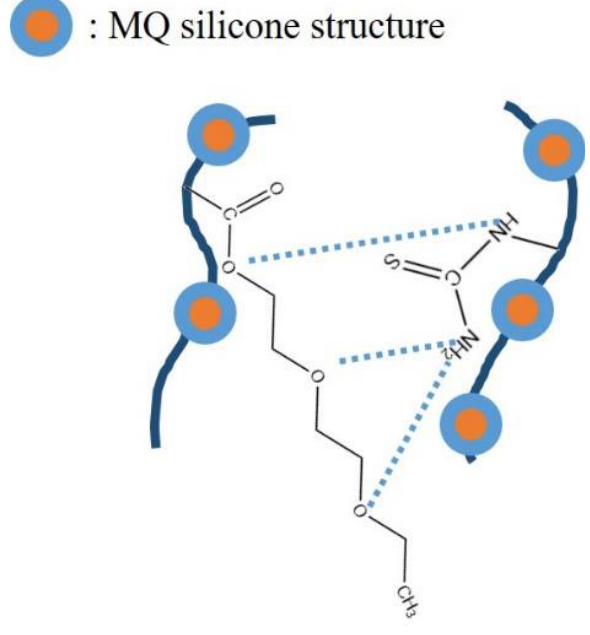
Figure 1. Synthesis of the polymer PTS.